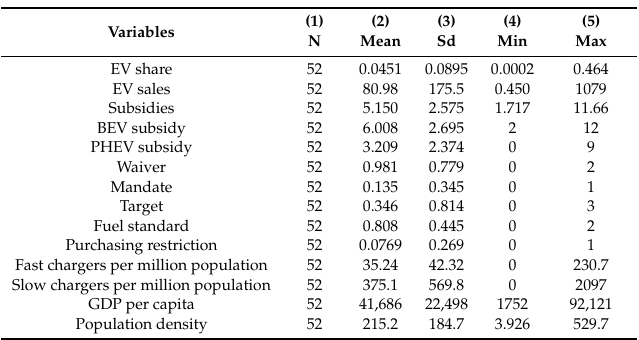
Table 4. Summary